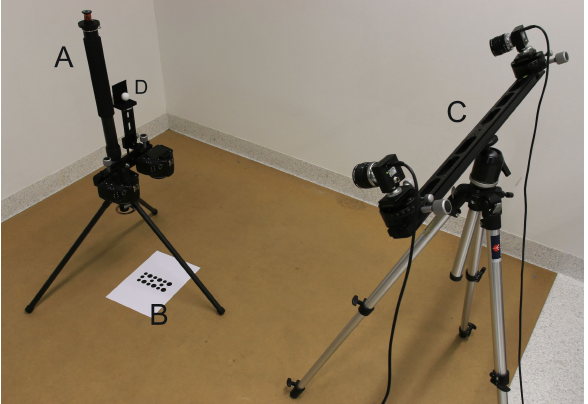
Figure 8: Setup for calibration of the T-shaped scanner struc- ture: The scanner prototype A tracks a target B positioned in its field-of-view, and the external stereo camera rig C simultaneously tracks the target B and the white sphere D on the the scanner structure that is afterwards used to track the scanner position.